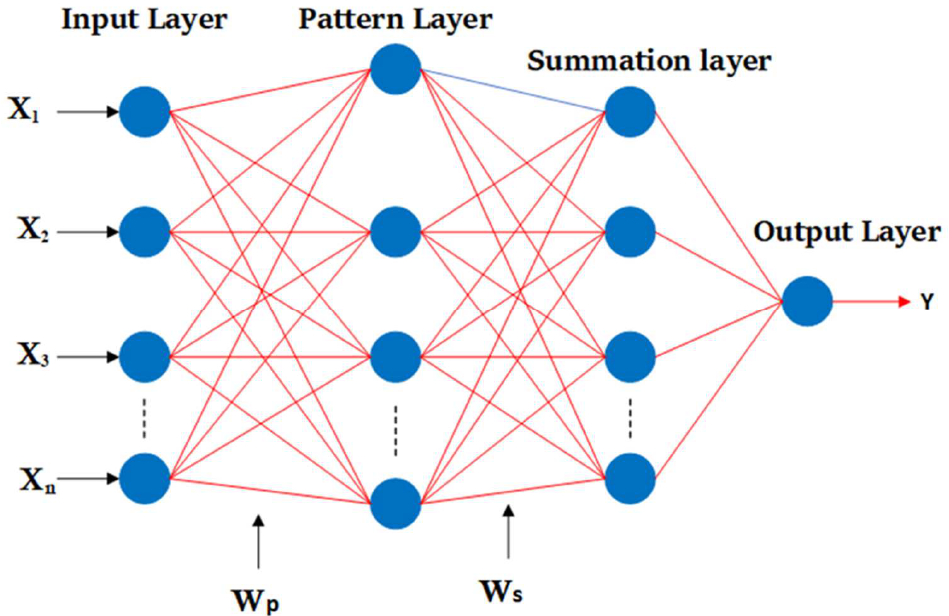
Figure 3. Conceptual representation of a GRNN [56].